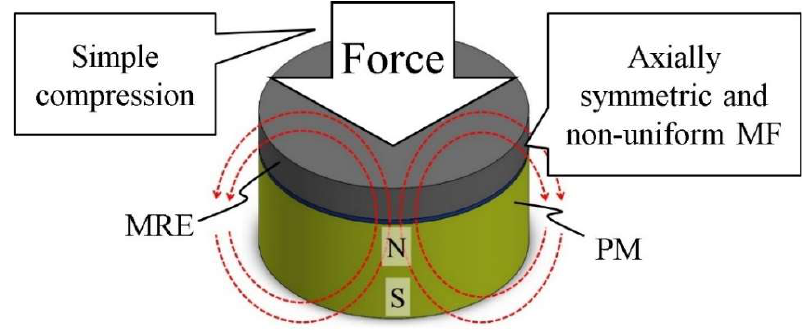
Figure 1. The study system. MRE—magnetorheological elastomer; MF—magnetic field; PM—permanent magnet. Dashed red curves show the MF lines. The MF is axial symmetric, but non-uniform in the vertical direction.